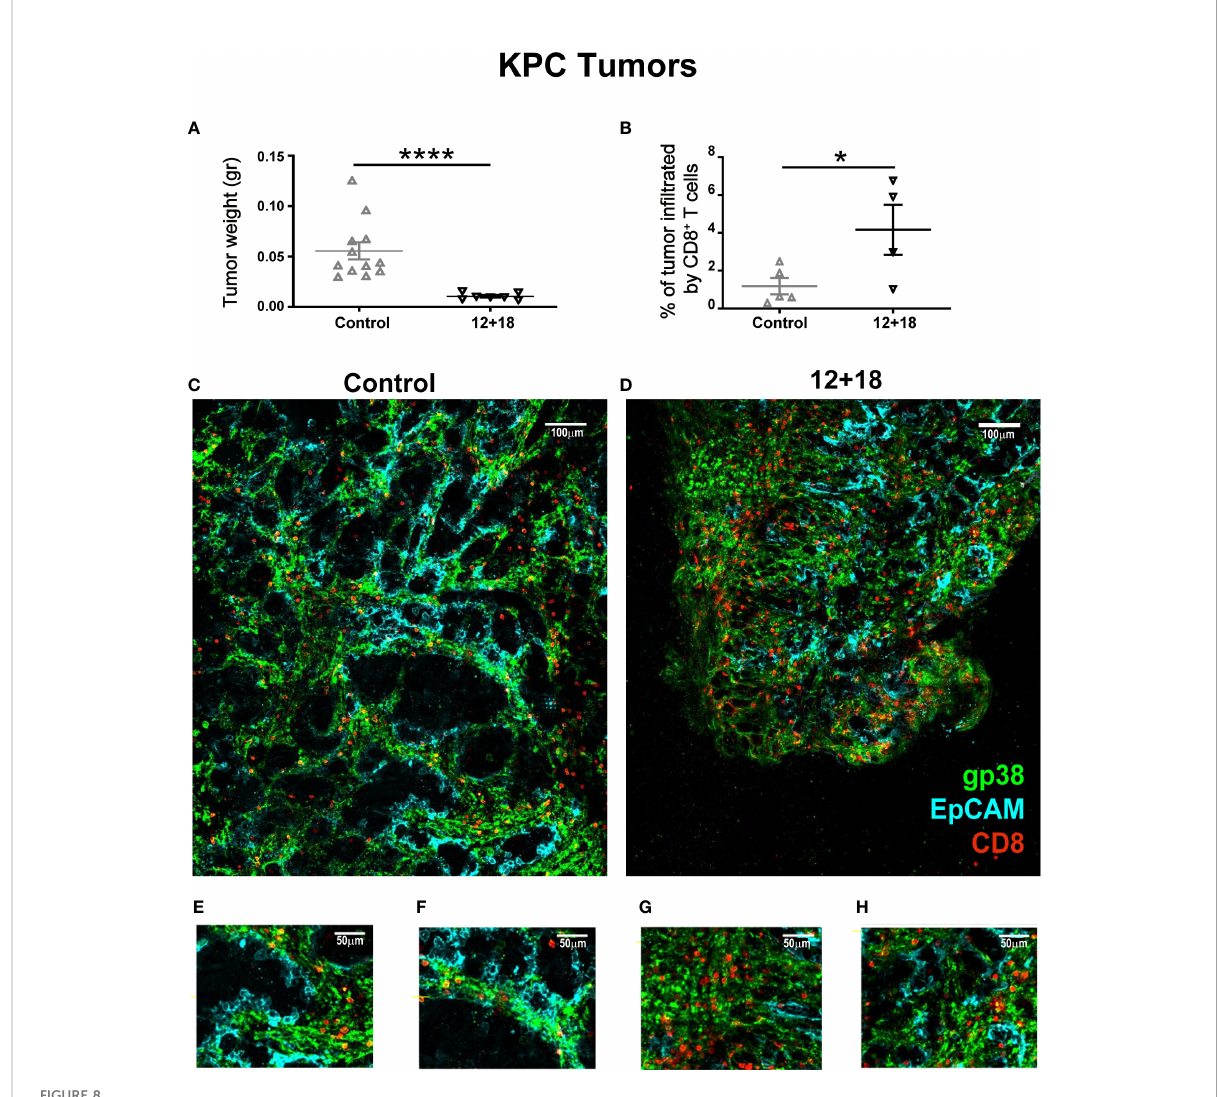
FIGURE 8 Effects of IL-12 plus IL-18 systemic expression on CD8 + T cell that in fi ltrate KPC tumors on OT-I mice. OVA neg KPC- bearing C57BL/6 OT-I mice were hydrodynamically injected (HI) with IL-12 plus IL-18 cDNA (12 + 18) or empty cDNA as the control. After 7 days post-HI mice were euthanized, and tumors were harvested, weighed, fi xed and included in a 5% agarose solution. Slides were made of 200µm using a Leica VT 1000S Vibratome and were stained with anti-CD8 (red), anti-gp38 (green) for stroma detection, anti-EpCAM (blue) for detecting epithelial (tumoral) cells. Images were taken with a DM500B upright microscope equipped with a SP5 confocal head (Leica). (A) KPC tumor weight at day 7 post-IH is shown from control or 12 + 18 OT-I mice. (B) Graph representing percentages of tumor area in fi ltrated by CD8 + T cells in each experimental group. Figures represent tumors from (C, E, F) control or (D, G, H) 12 + 18 mice, (C, D) reconstructing big tumor areas or (E-H) enlarging regions of interest with a 25x magni fi cation. Statistical analysis was performed by Student T test (A, B) . Values of *p<0.05, ****p<0.0001 were consider signi fi